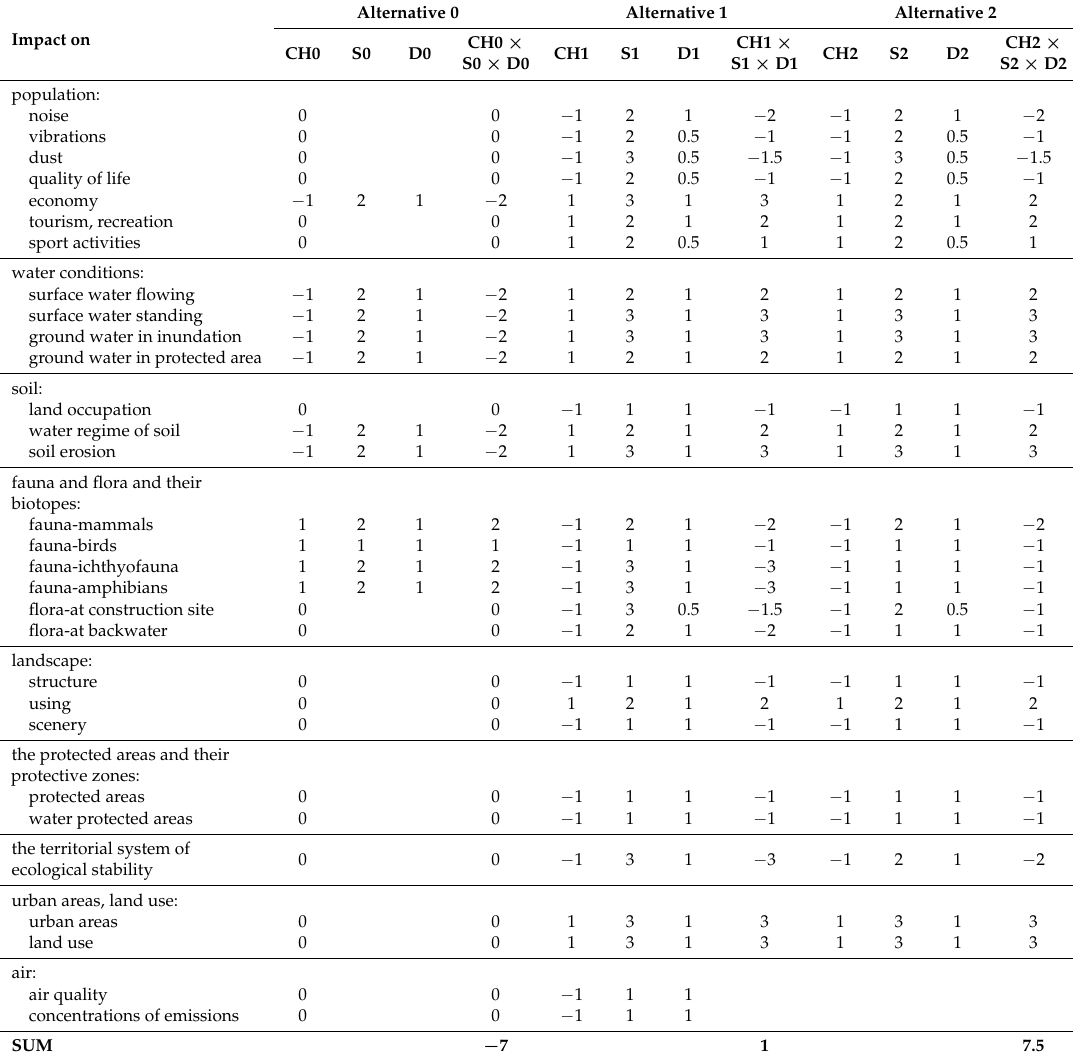
Table 1. Quantification of impacts and comparison of